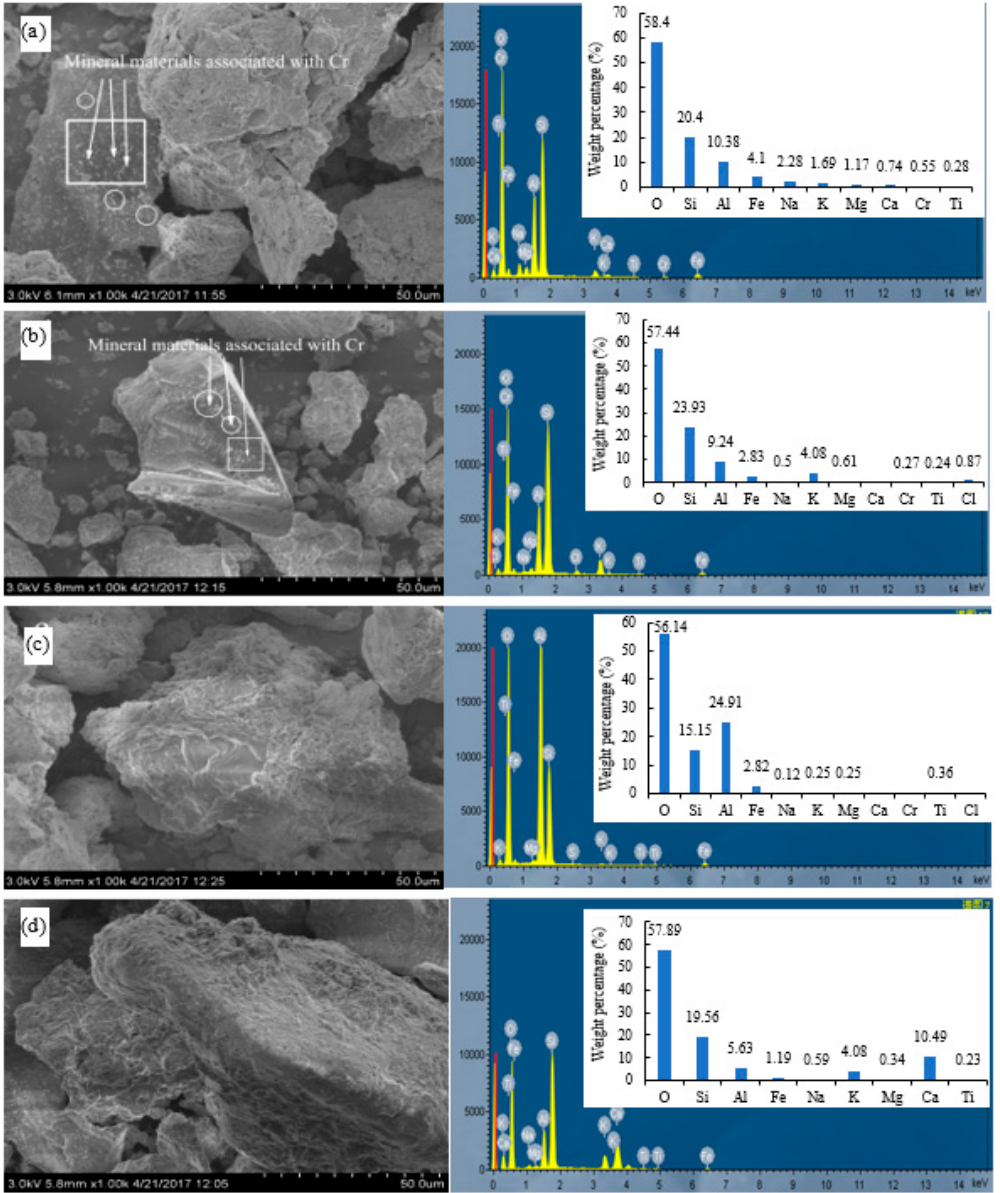
Figure 6. SEM image and EDS of the soils before and after leaching by different acids. ( a ) Original soil, ( b ) soil leached by HCl, ( c ) soil leached by CA, ( d ) soil leached by OX.